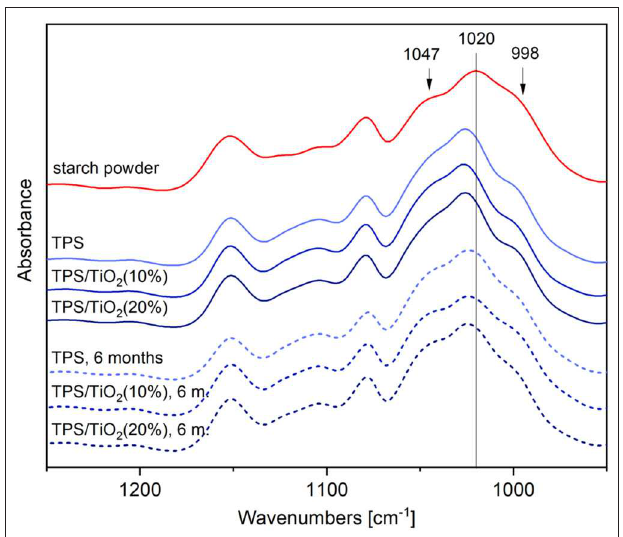
FIGURE 3 | IR spectra of TPS and TPS/TiO 2 composites after preparation and after 6 months of aging; the peaks at 998, 1020, and 1047 cm − 1 are connected with the changes of crystalline structure of the TPS matrix.